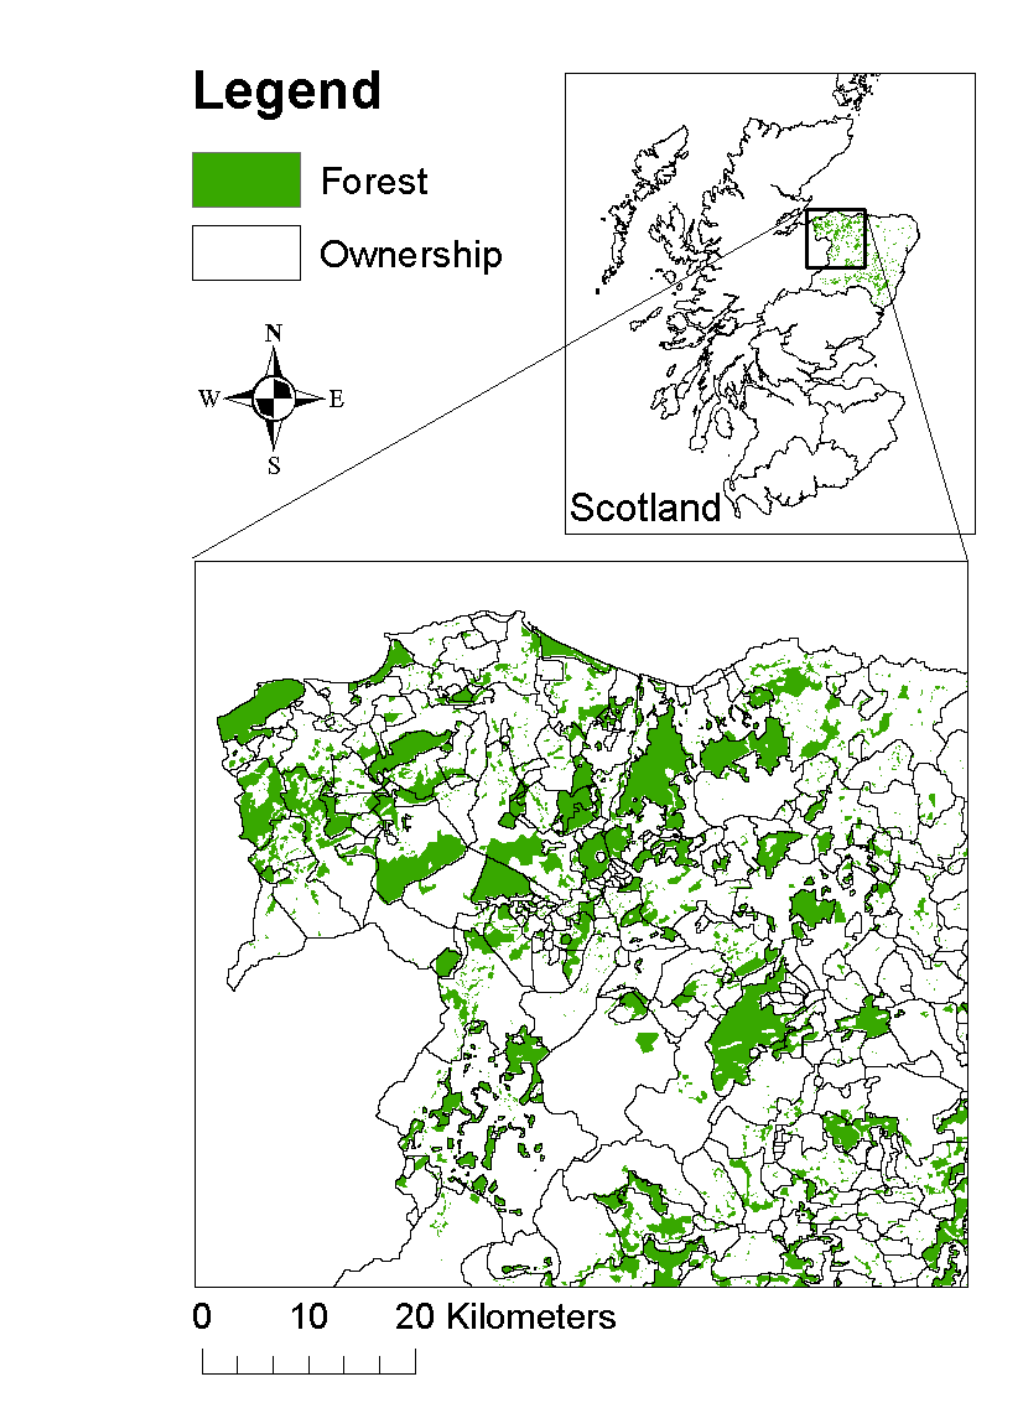
Fig. 1. Forest and ownership boundaries in